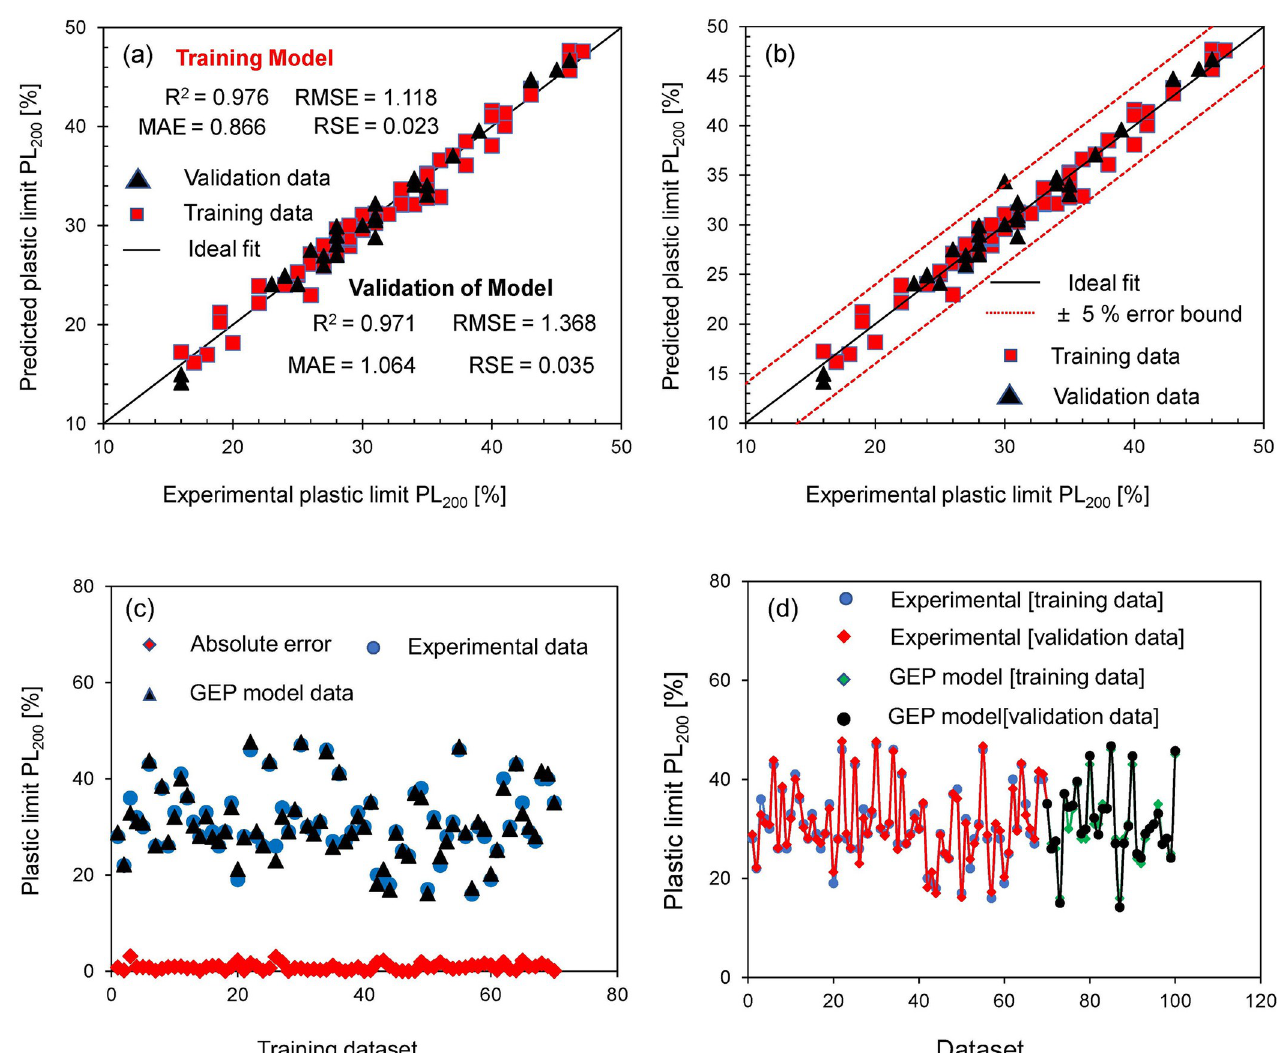
Fig 8. Performance assessment of prediction model based on different criteria; (a) comparison of statistical parameters for training and validation data; (b) ± 5% error bound for prediction model; (c) comparison of experimental data, GEP model data and absolute error; (d) comparison of experimental data and GEP prediction model data against training and validation